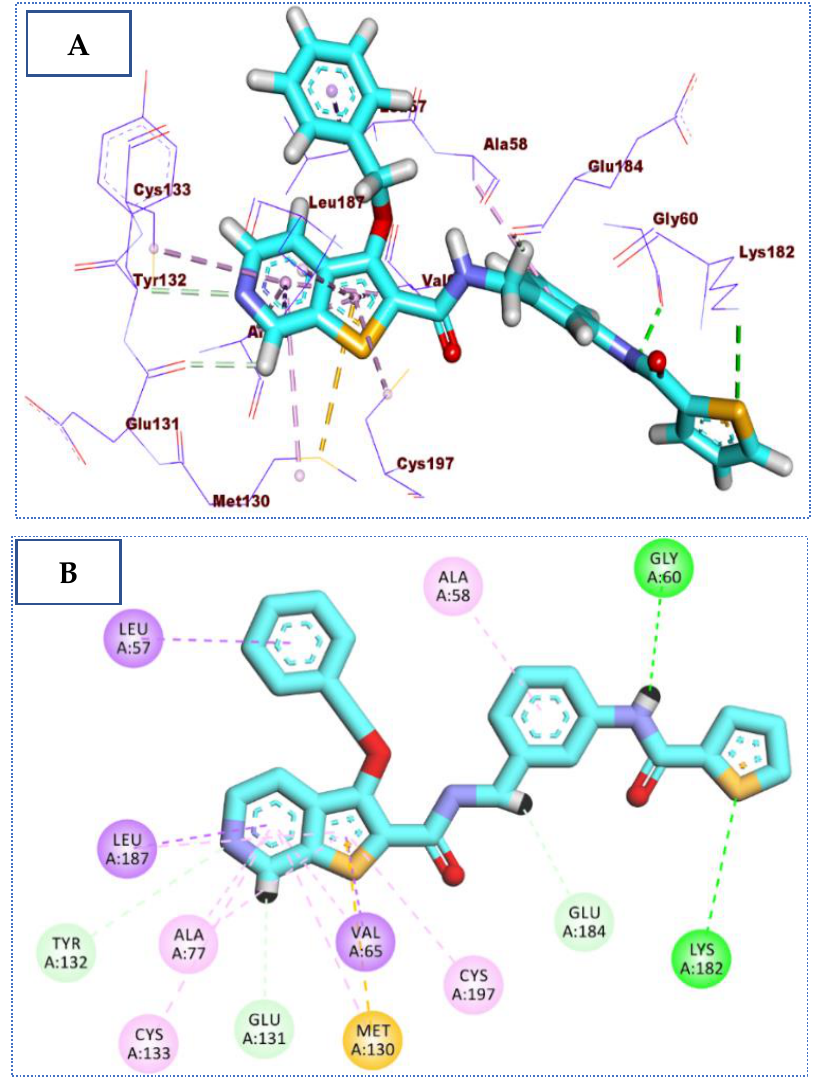
Figure 9. ( A ) The 3D and ( B ) 2D binding of 72 in the active site of BMP-2-inducible kinase (hydrogen bonds = green dashed lines, electrostatic interactions = orange dashed lines, pi-pi interactions = purple dashed lines, and pi-alkyl interactions = light pink dashed lines).